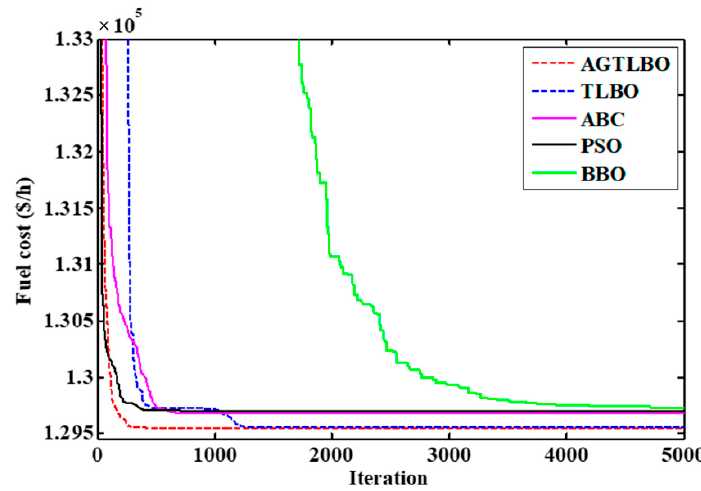
Figure 13. Convergence of algorithms for Case 12. In addition, the detailed results for the different test cases on the IEEE-30 bus test system, including the reactive power generation in the value of the generator, the voltage magnitude at all the buses and the transmission power via lines, are shown in Table 19. Table 19. The state variables for the best solutions for different test cases in the IEEE 30-bus system.